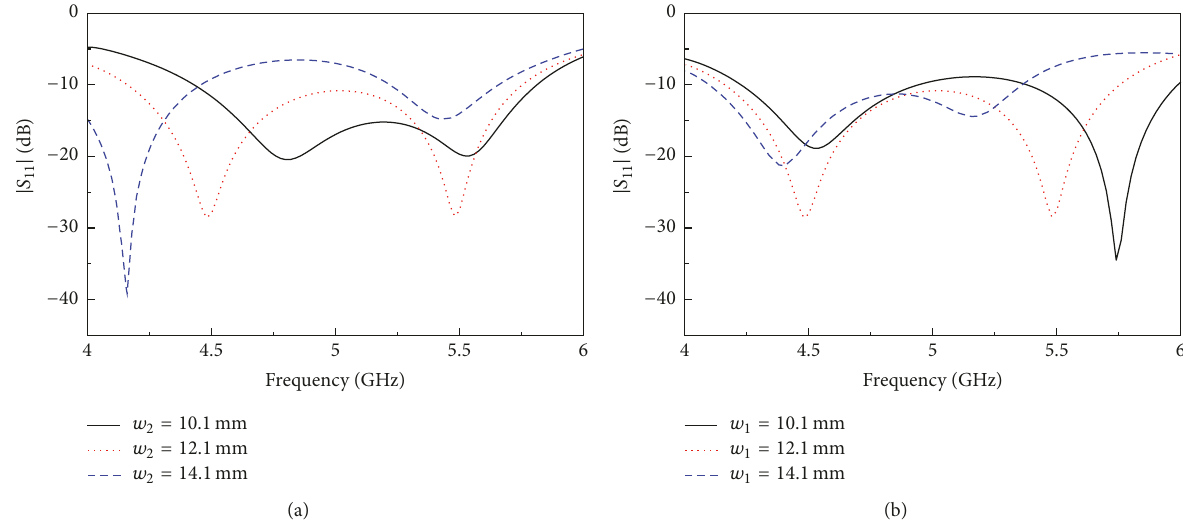
Figure 4: Simulated reflection coefficients of antenna III as a function of frequency for different cell widths. (a) 𝑤 1 = 𝑤 4 = 12.1 mm, 𝑤 = 𝑤 = 𝑤 . (b) 𝑤 = 𝑤 = 12.1 mm, 𝑤 2 3 2 3